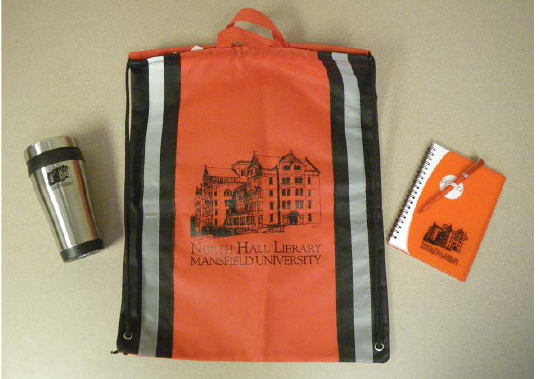
Library promotional items use the library